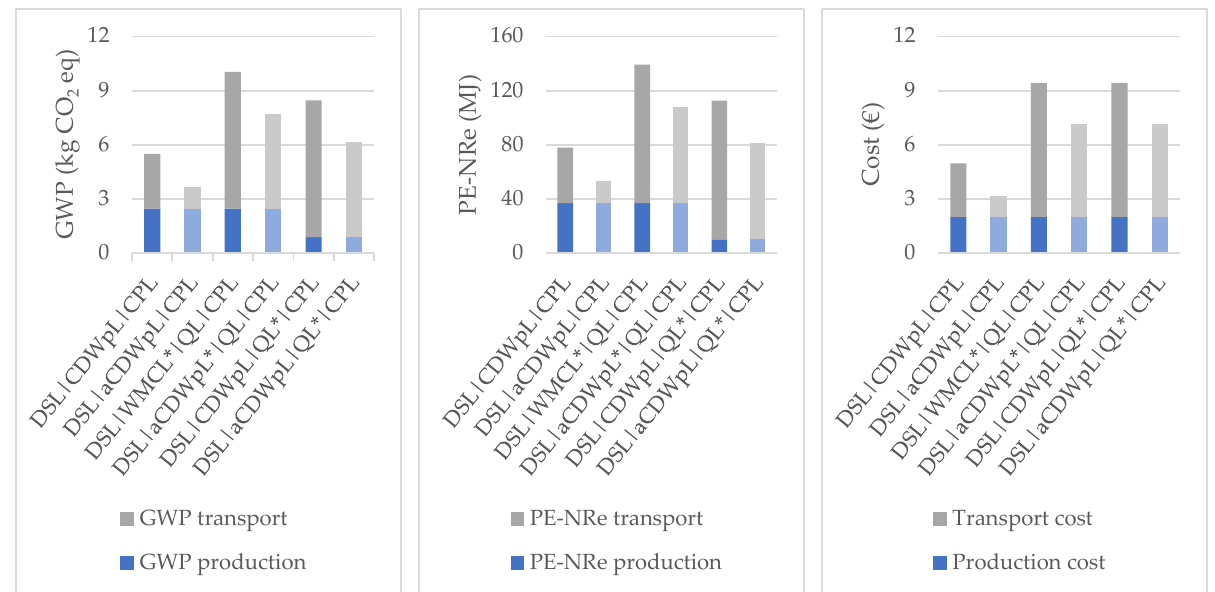
Figure 7. Comparison between Scenario 1, darker color, and Scenario 2a, lighter color.